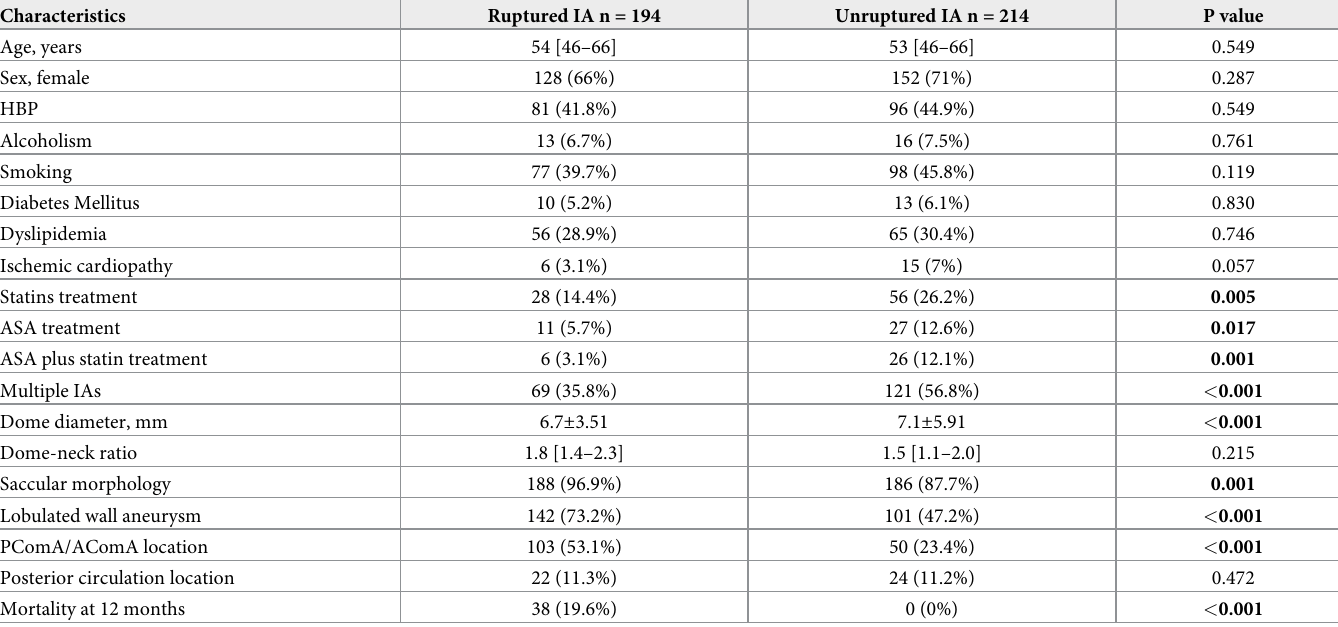
Table 1. Univariate analysis according to aneurysm state at